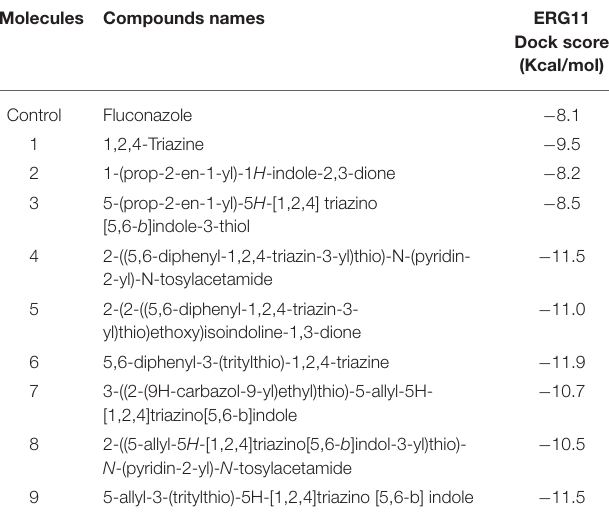
TABLE 1 | Docking score (Kcal/mol) of the CYP51 with nine